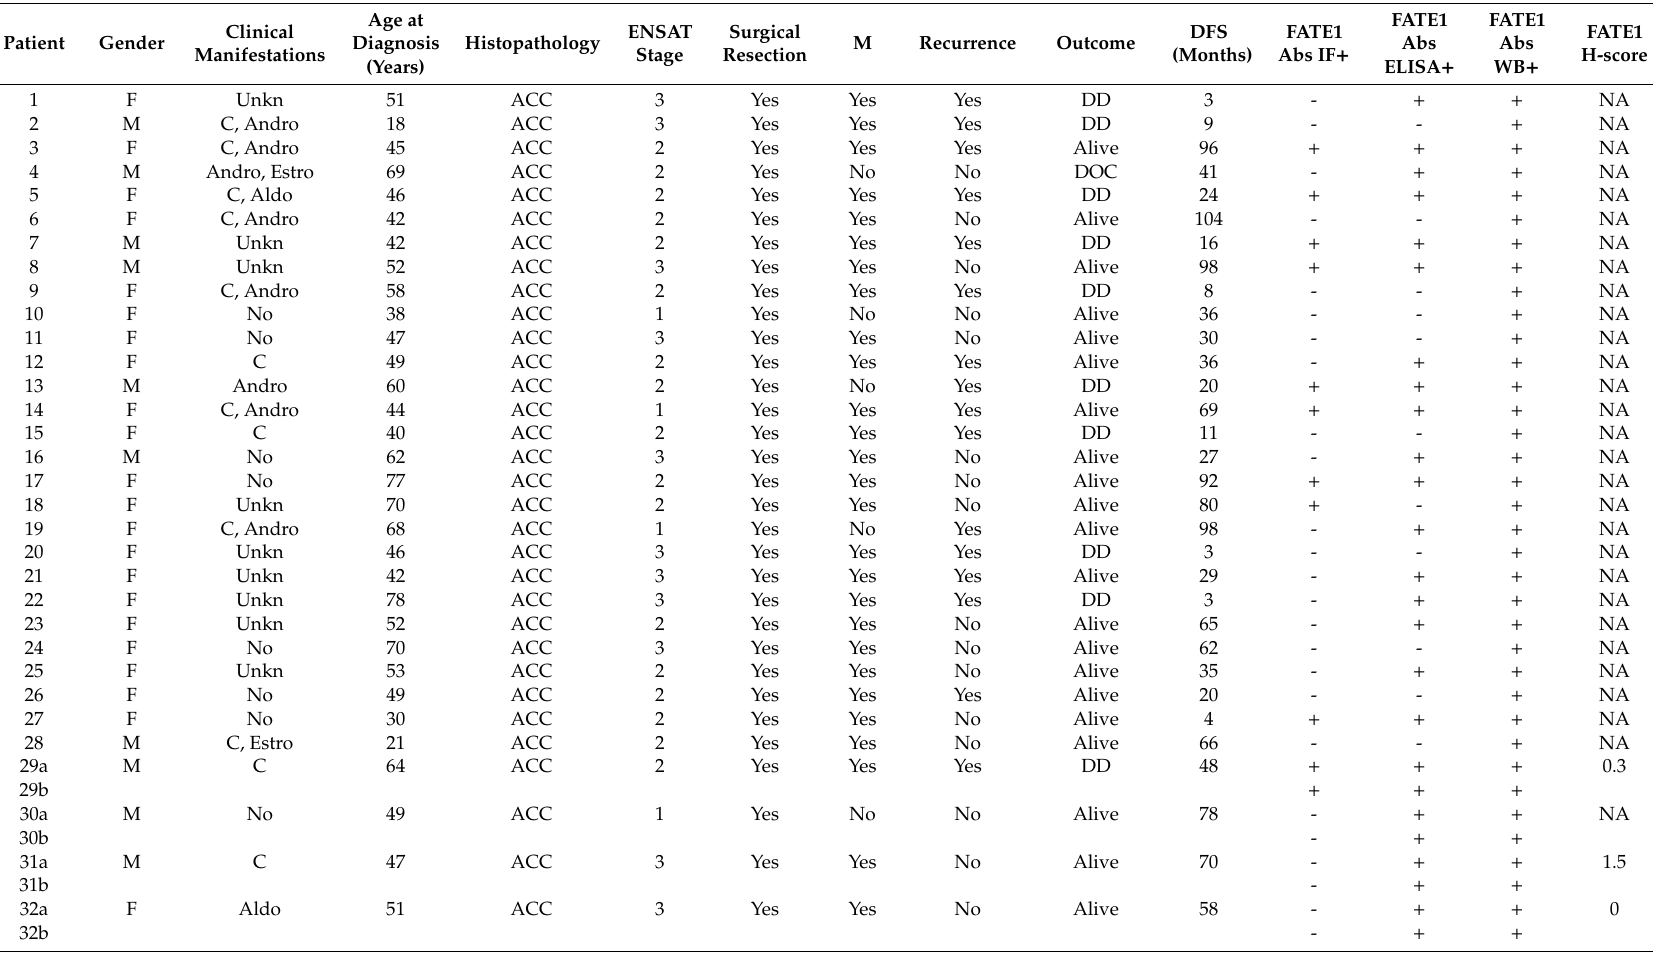
Table 4. Clinical, histopathological and serological features of adults with ACT in this study. For patients 29 to 34, serum samples labelled with a were taken before surgery, samples labelled with b after